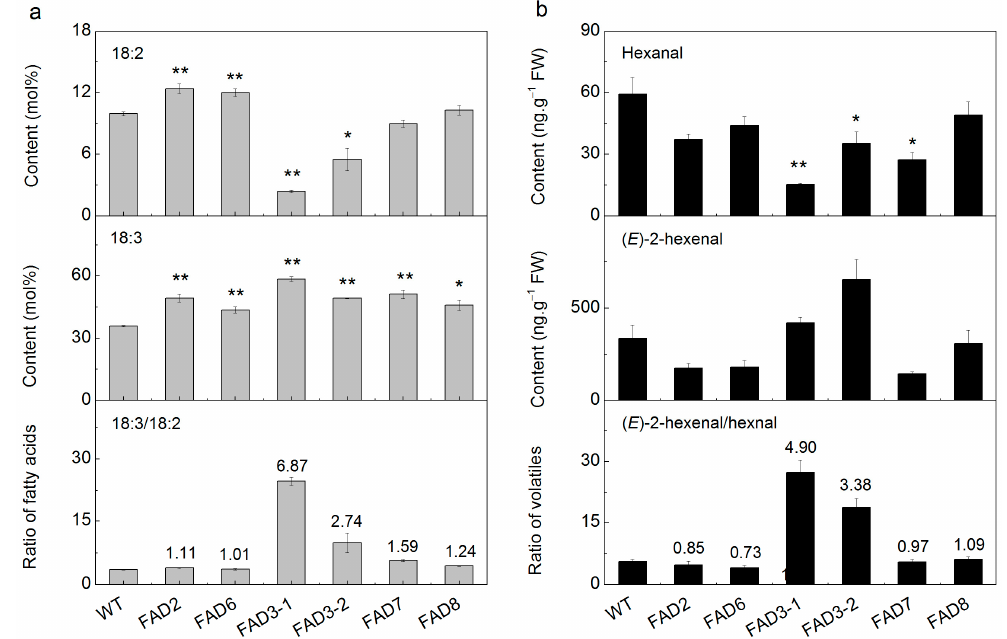
Figure 4. Fatty acid and volatile compositions of transgenic tobacco and wild-type (WT) plant leaves. ( a ) Fatty acid composition; ( b ) volatile production. Relative quantification of volatile compounds was performed using the peak area of the internal standard as a reference. Data are the mean ± stand error from three independent experiments. Significant differences are indicated with asterisks above the bars (* p ≤ 0.05 and ** p ≤ 0.01). Numbers above the bars represent fold changes relative to WT.